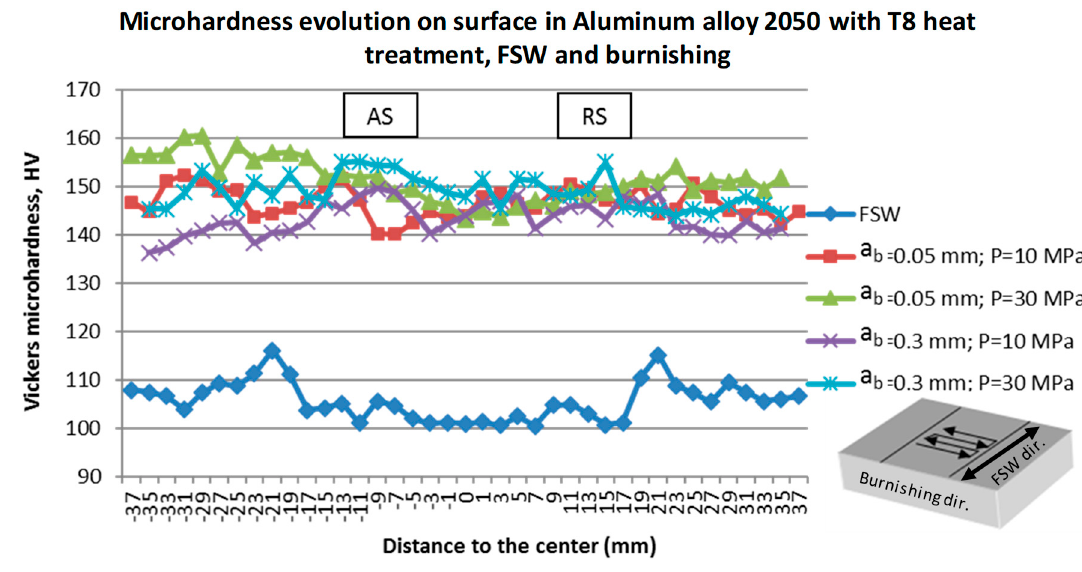
Figure 13. Microhardness evolution with burnishing applied perpendicular to the welding direction.